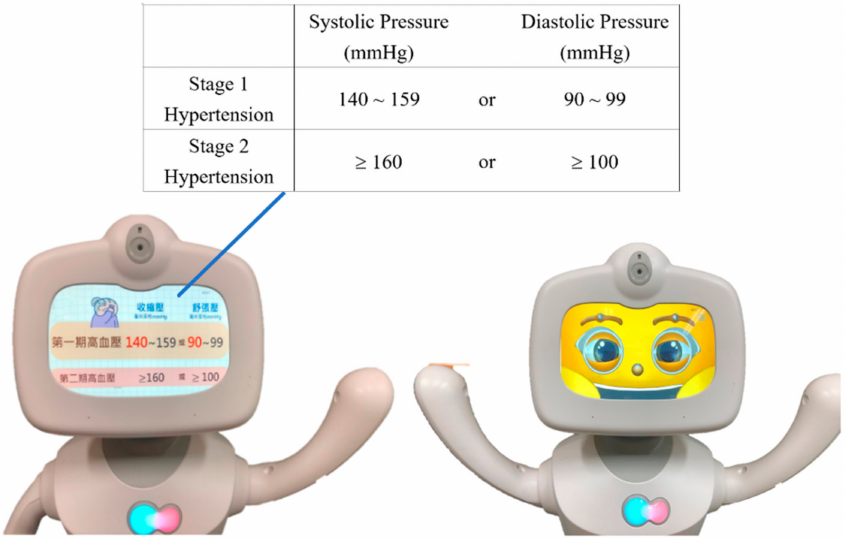
Figure 1. The robot-assisted learning